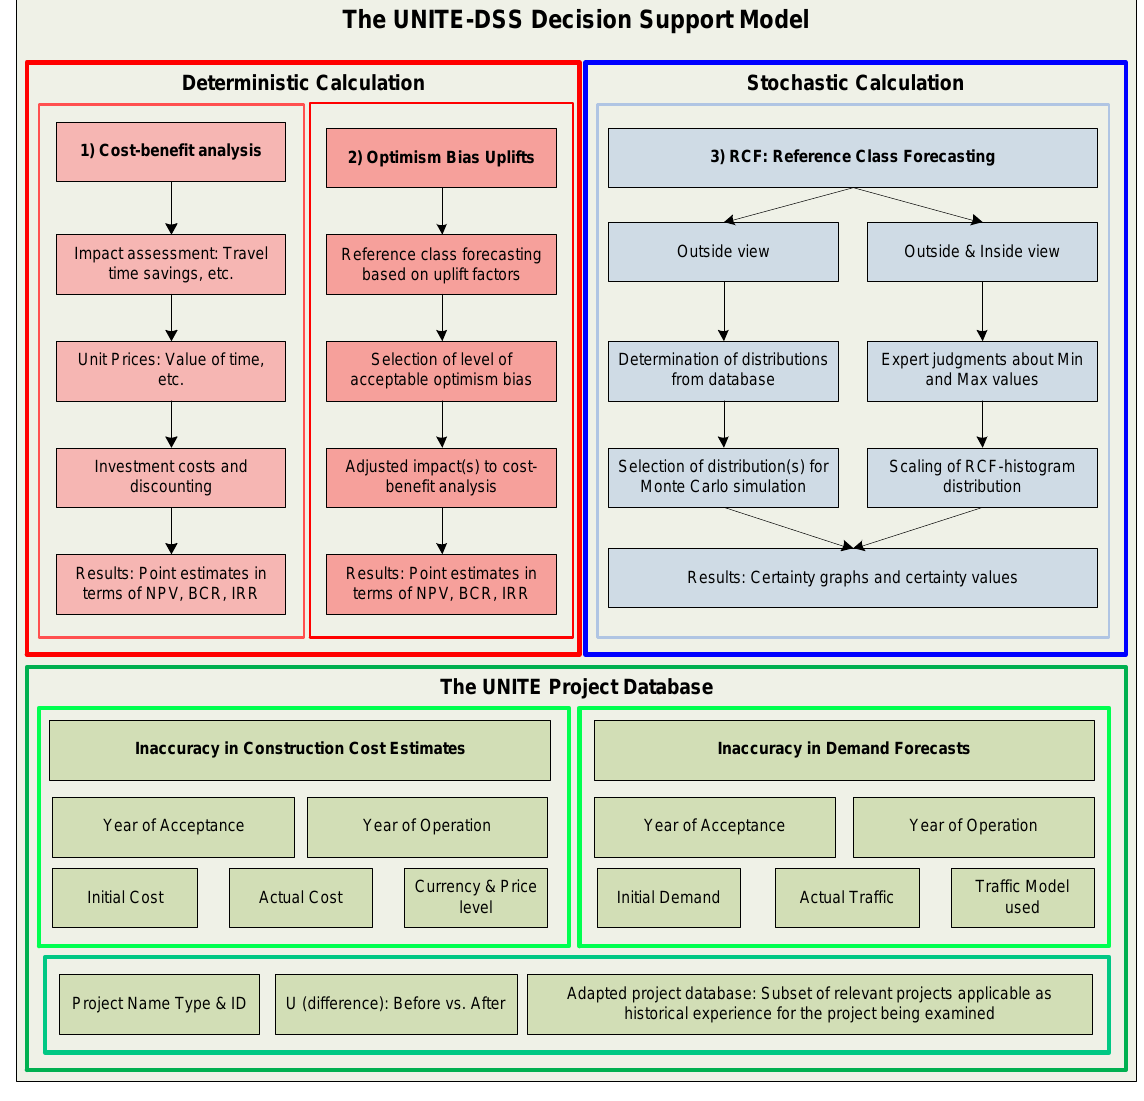
Figure 3. Overview of the UNITE-DSS